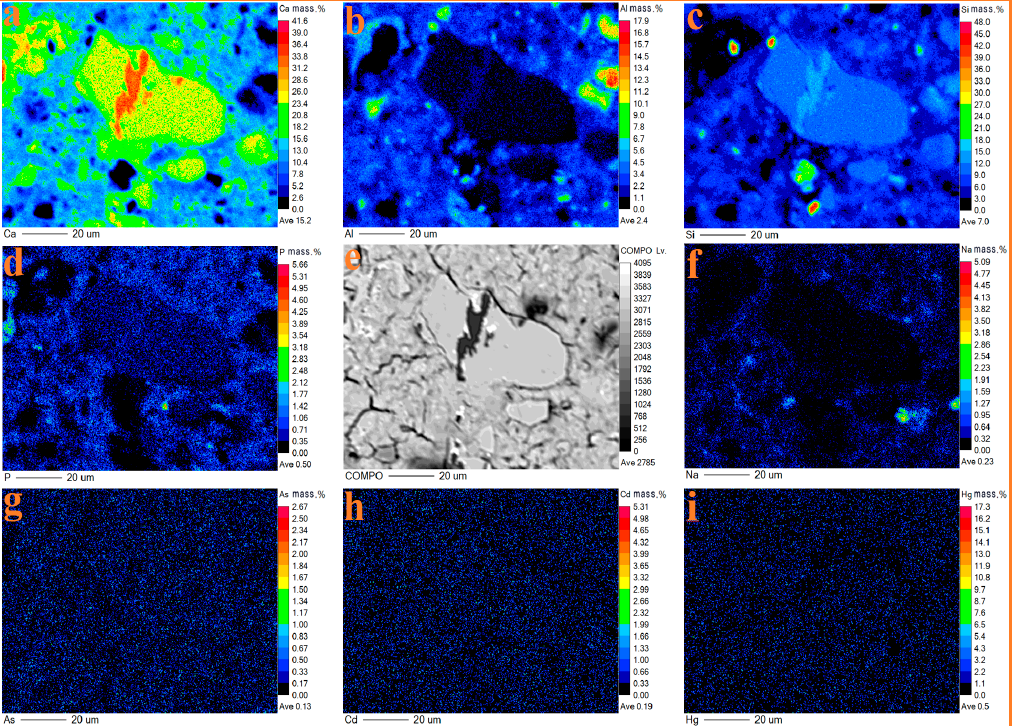
Figure 14. BSE image ( e ) and elemental distribution maps of Ca, Al, Si, P, Na, As, Cd, and Hg ( a – d , f – i ) of CWM20-28 d.